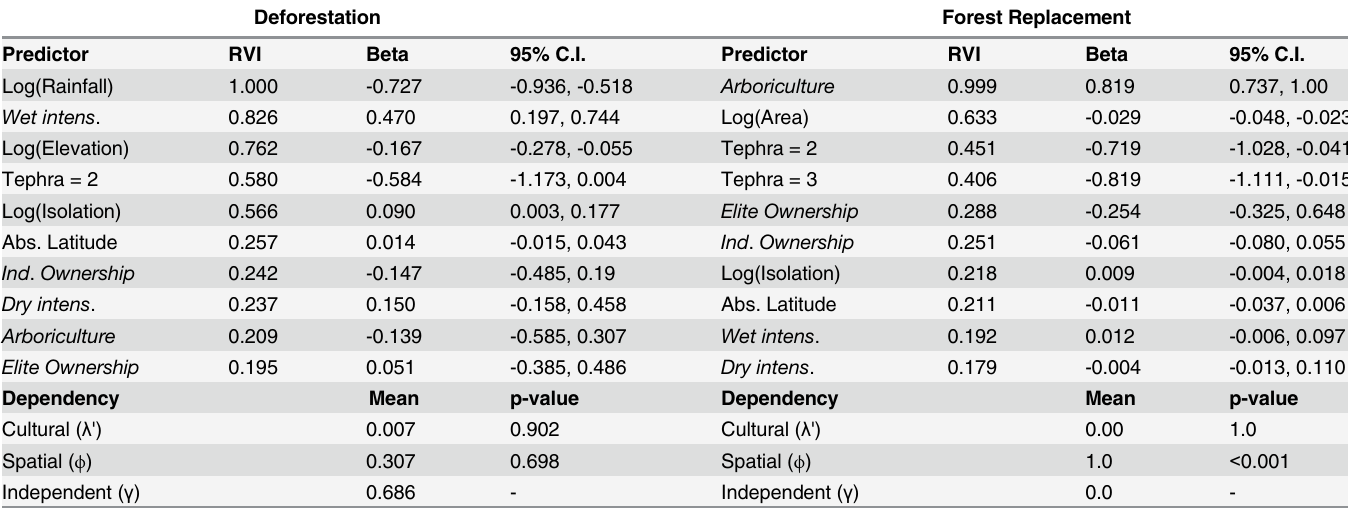
As for Table 1 but predicting deforestation (n = 80) and forest replacement (n = 76) from the fi ve most important ecological predictors together with the agricultural intensi fi cation and land tenure cultural predictors. Cultural predictors in italics